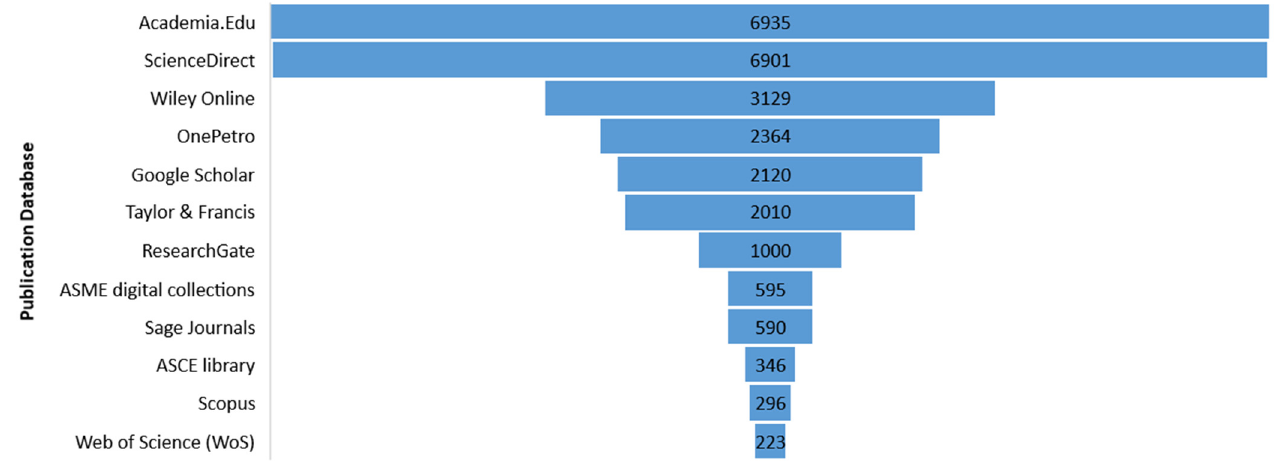
Figure 1. Result of literature search from different publication databases on “marine hose”.